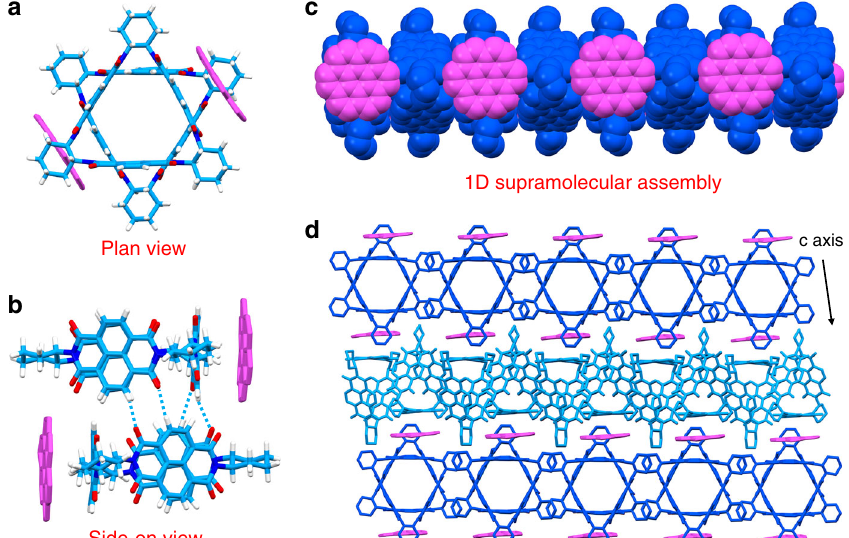
Fig. 2 Solid-state superstructure of CNC-T. a Plan view of a capped-sticks representation demonstrating the face-to-face packing between COR and NDI- Δ . b Side-on view of a capped-sticks representation indicating that two adjacent NDI- Δ molecules are linked by [C – H···O] hydrogen bonding. c 1D Columnar superstructure composed of inner NDI- Δ nanotube and outer COR molecules. d Solid-state superstructure of CNC-T illustrating the layer-by- layer stacking along the c